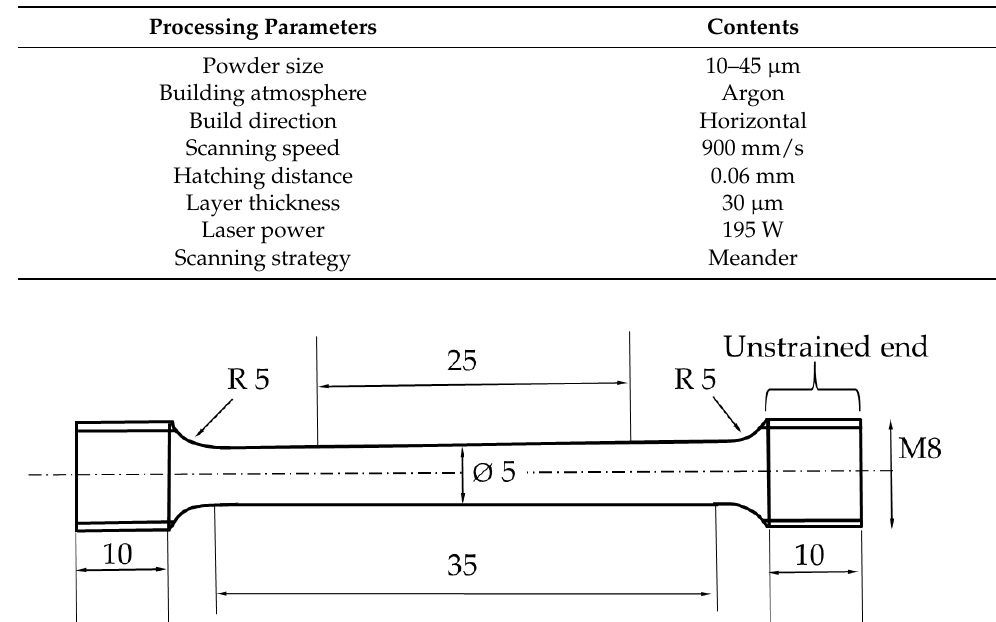
Table 2. Processing parameters for 316 L stainless steel processed with L-PBF.